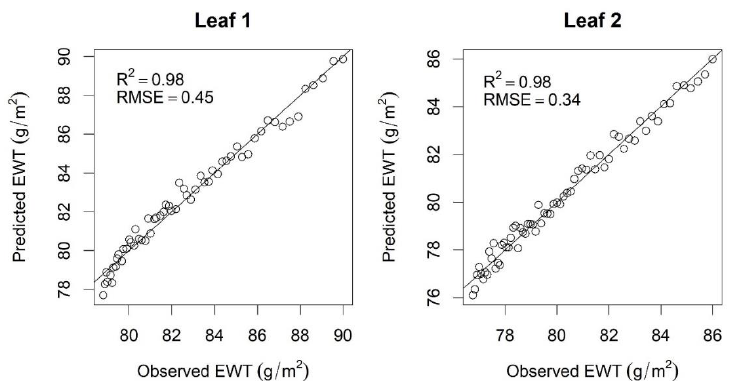
Figure 4. Observed and predicted equivalent water thickness (EWT, g m − 2 ) of two silver birch leaves exposed to increasing VPD under constant levels of CO 2 concentrations and light intensity after detaching the leaf from the branch. Prediction was made using reflectance at 1550 nm wavelength as a predictor. Reflectance wavelength was selected based on the lowest RMSE in the estimation of EWT. The line represents 1:1 relationship. The estimates were non-biased. Reflectance was transformed to EWT with coefficients of − 4310.4 and − 4631.1, and constants of 700.7 and 715.3 for leaves 1 and 2, respectively.